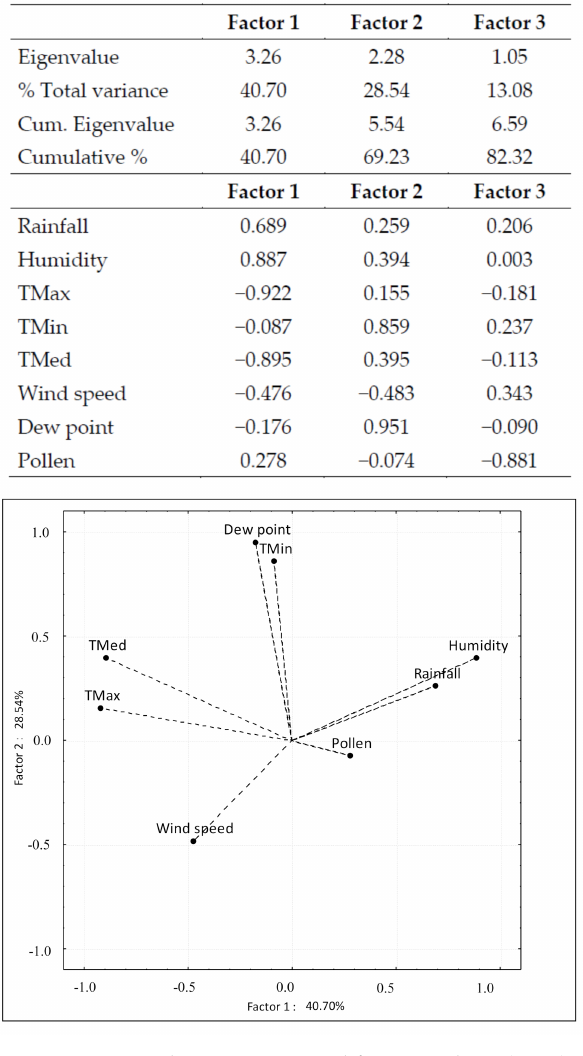
Figure 7. Principal components and factor analysis (PCA). Rotation varimax. Extraction principal components for daily values for Olea pollen and main meteorological variables during the three years of